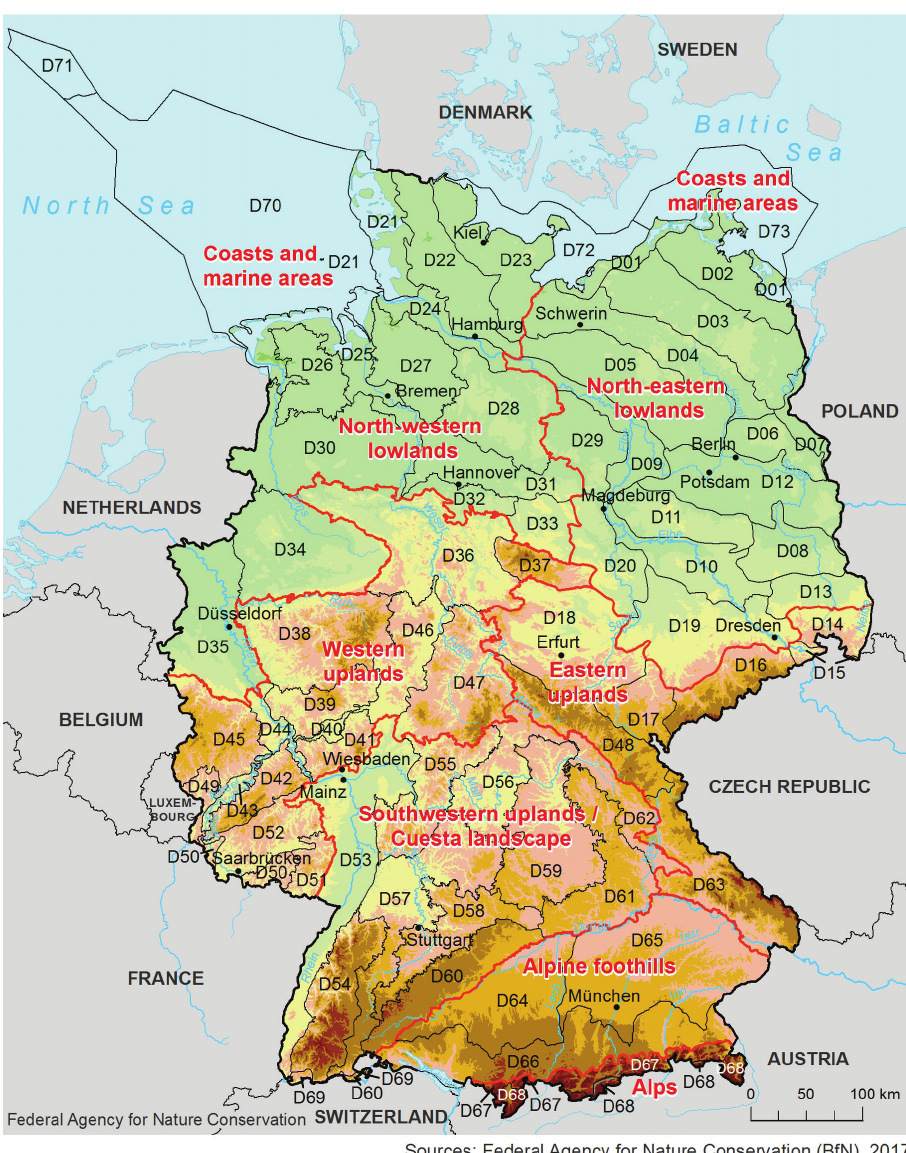
Figure 3. Map of the regions delimited for the regional threat classification of habitats (major landscape regions; red outlines). For ecological characterisation, Germany can be subdivided into natural units. The figure is based on the system of Meynen and Schmithüsen et al. (1953–1962). For the application in the habitats directive (Natura 2000) and the risk assessment of habitats Ssymank, A (1994) has restructured and generalised the system. The classification of major landscape units is based on physiographic units (black outlines; for a reference list see Annex V.6, Finck et al. [2017]) according to Ssymank et al. (1998) and Petersen et al.